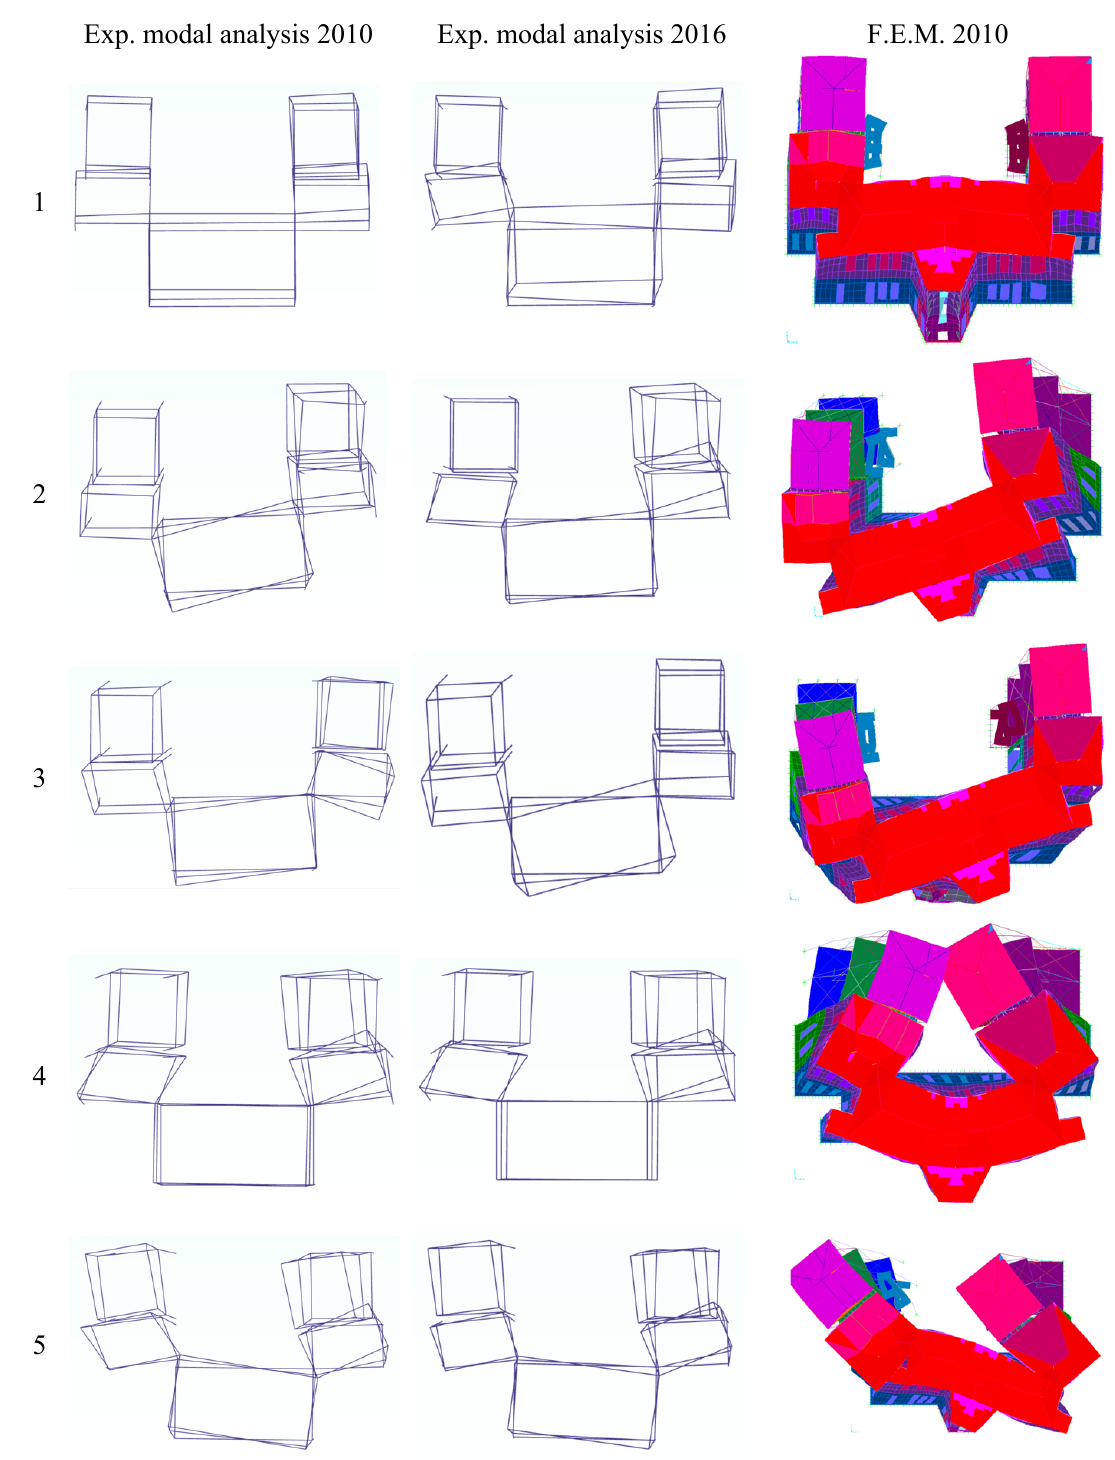
Figure 5. First 5 modal shapes obtained with the experimental modal analysis before (2010) and after (2016) the 2012 structural interventions and comparison with those calculated with the finite element model (FEM) updated to match the 2010